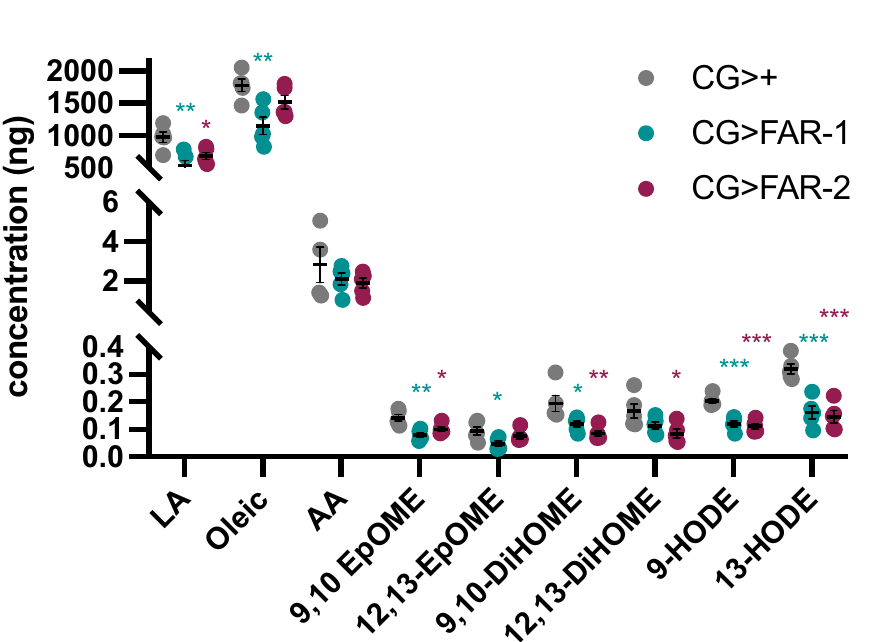
Fig 4. Metabolite abundance in FAR expressing and control hemolymph. A) Fly hemolymph samples were analyzed for abundance of various lipids. 9(10)- and 12(13)- EpOME, 9- and 13-HODE and arachidonic acid were depleted in FAR-1 expressing flies. Statistics shown as an unpaired t-test and error bars show mean+SEM. Asterisk color for significance matches sample color. All raw data available in supplemental materials.